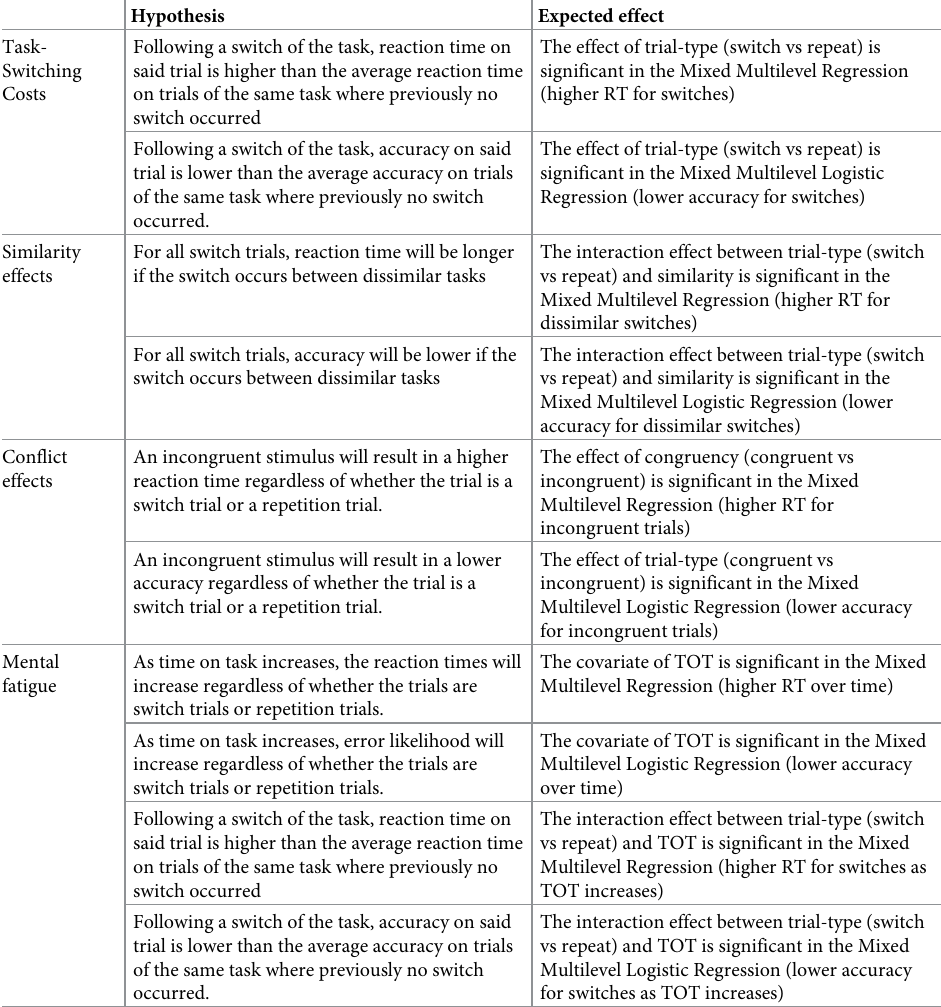
Table 1. Expected results with corresponding